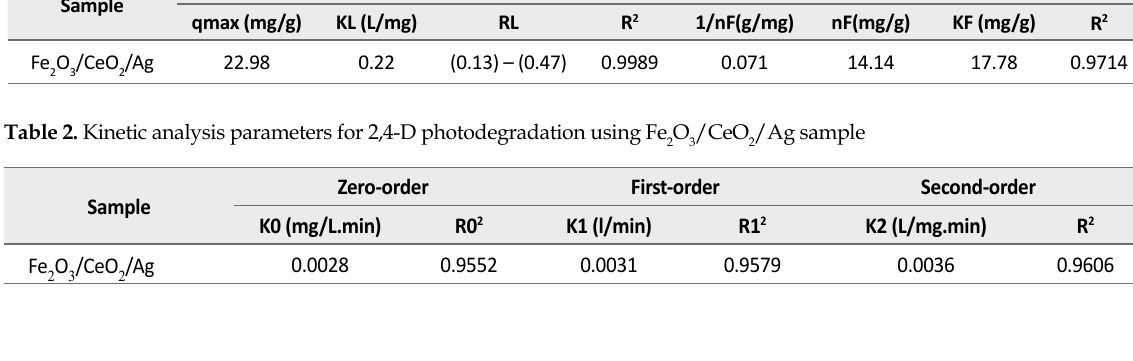
O /CeO /Ag sample 2 3 2